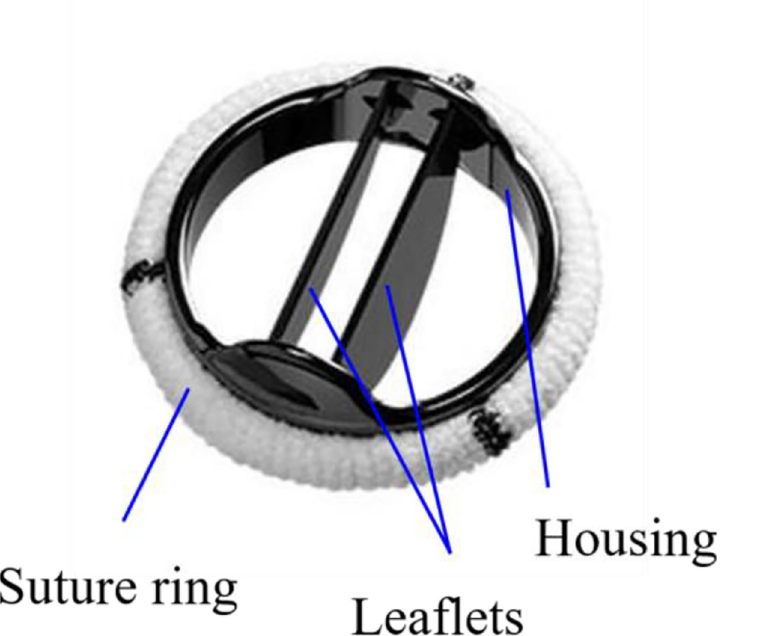
Fig 1. Bileaflet mechanical heart valve (BMHV): St. Jude Masters HP series valve.